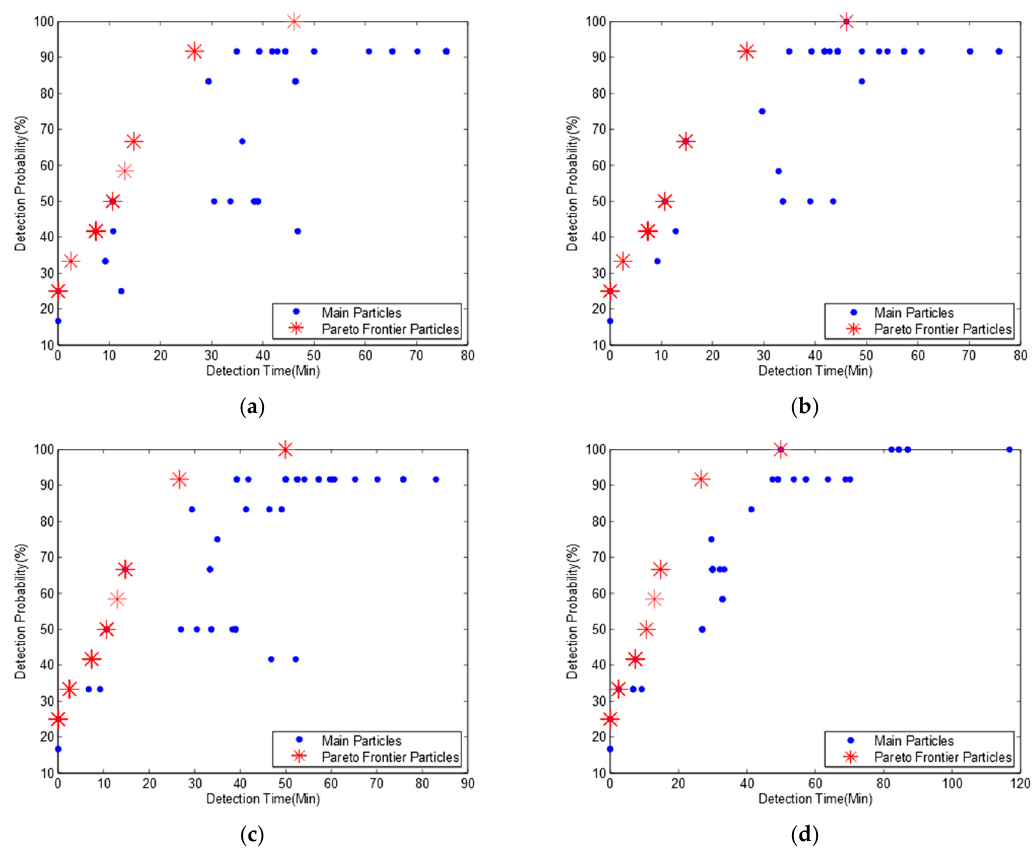
Figure 2. Pareto frontiers for river network A with three monitoring nodes and a detection threshold of 0.01 mg/L. ( a ) Pareto frontier of the first simulation; ( b ) Pareto frontier of the second simulation; ( c ) Pareto frontier of the third simulation; ( d ) Pareto frontier of the fourth simulation. Table 3. Optimal deployment solutions on Pareto frontier for river network A with a detection threshold of 0.01 mg/L.